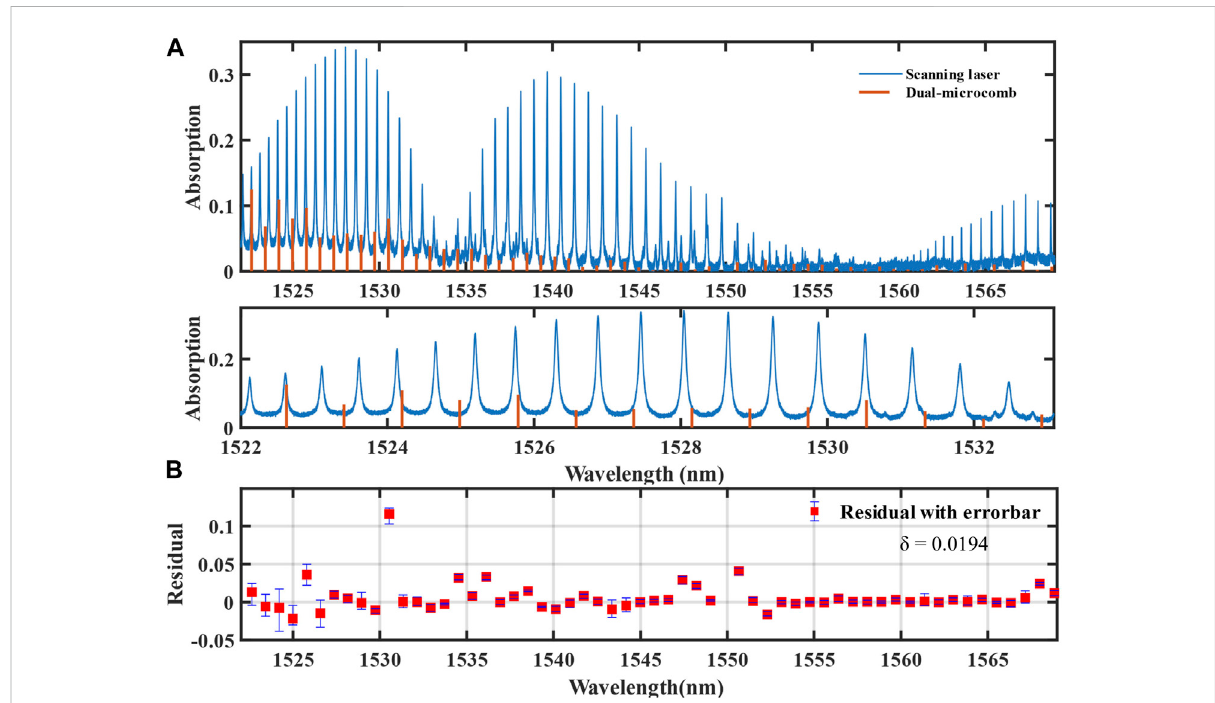
Gas absorption spectra test. (A) The gas absorption spectra measured by the wavelength-calibrated scanning laser and dual-microcomb. The absorption is de fi ned as 1 — T, with T the transmittance of the gas cell. The lower panel represents the spectra range between 1522 nm and 1533 nm. (B) The residual difference with errorbar between the two